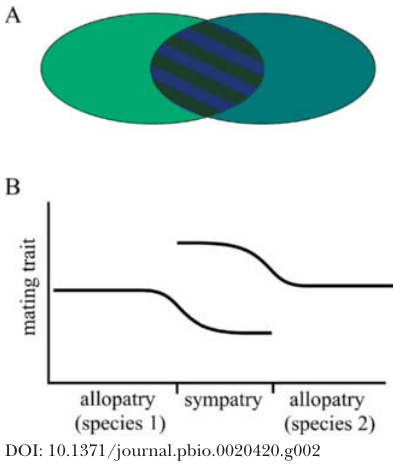
Figure 2. The Pattern of Reproductive Character Displacement (A) Reproductive character displacement due to the presence of an area of overlap between two populations (differences in mating characteristics are represented by color changes, with the hatched area showing divergence in sympatry). Reproductive character displacement can also occur when the sympatric and allopatric areas are not contiguous. (B) Reproductive character displacement can appear as a cline in mating cues or mating preferences (y-axis), with divergence originating in the area of sympatry and spreading into areas of